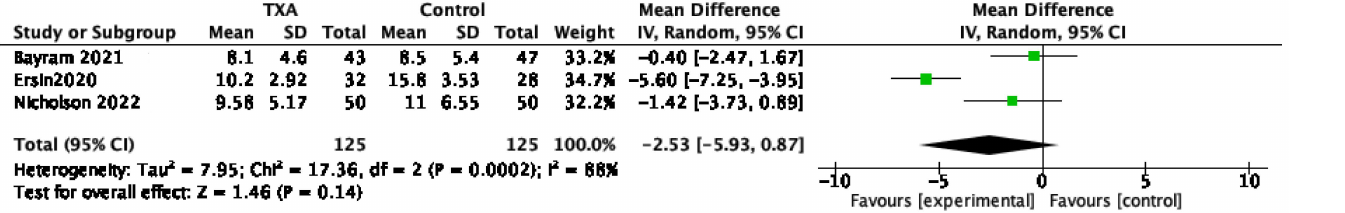
Figure 7. Forest plot and meta-analysis of the irrigation amount used. The centre of each square represents the weighted mean differences for individual trials, and the corresponding horizontal line stands for a 95% confidence interval. The diamonds represent pooled results